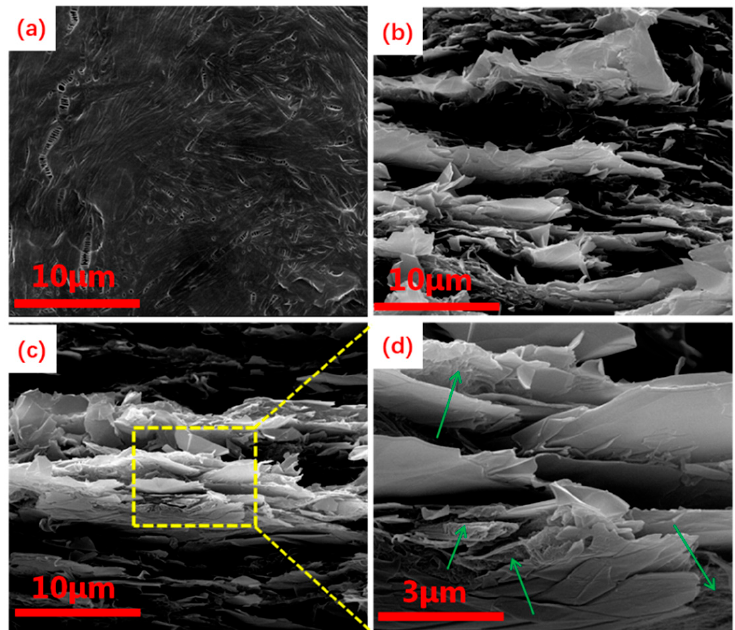
Figure 3. ( a ) SEM image of the cross section of PEO/CNF-FLG 0%; ( b ) SEM image of the cross section of PEO/CNF-FLG 50%; ( c ) SEM image of the cross section of PEO/CNF-FLG 80%; ( d ) SEM image of the cross section of PEO/CNF-FLG 80% at high magnification. The green arrows indicate CNFs.